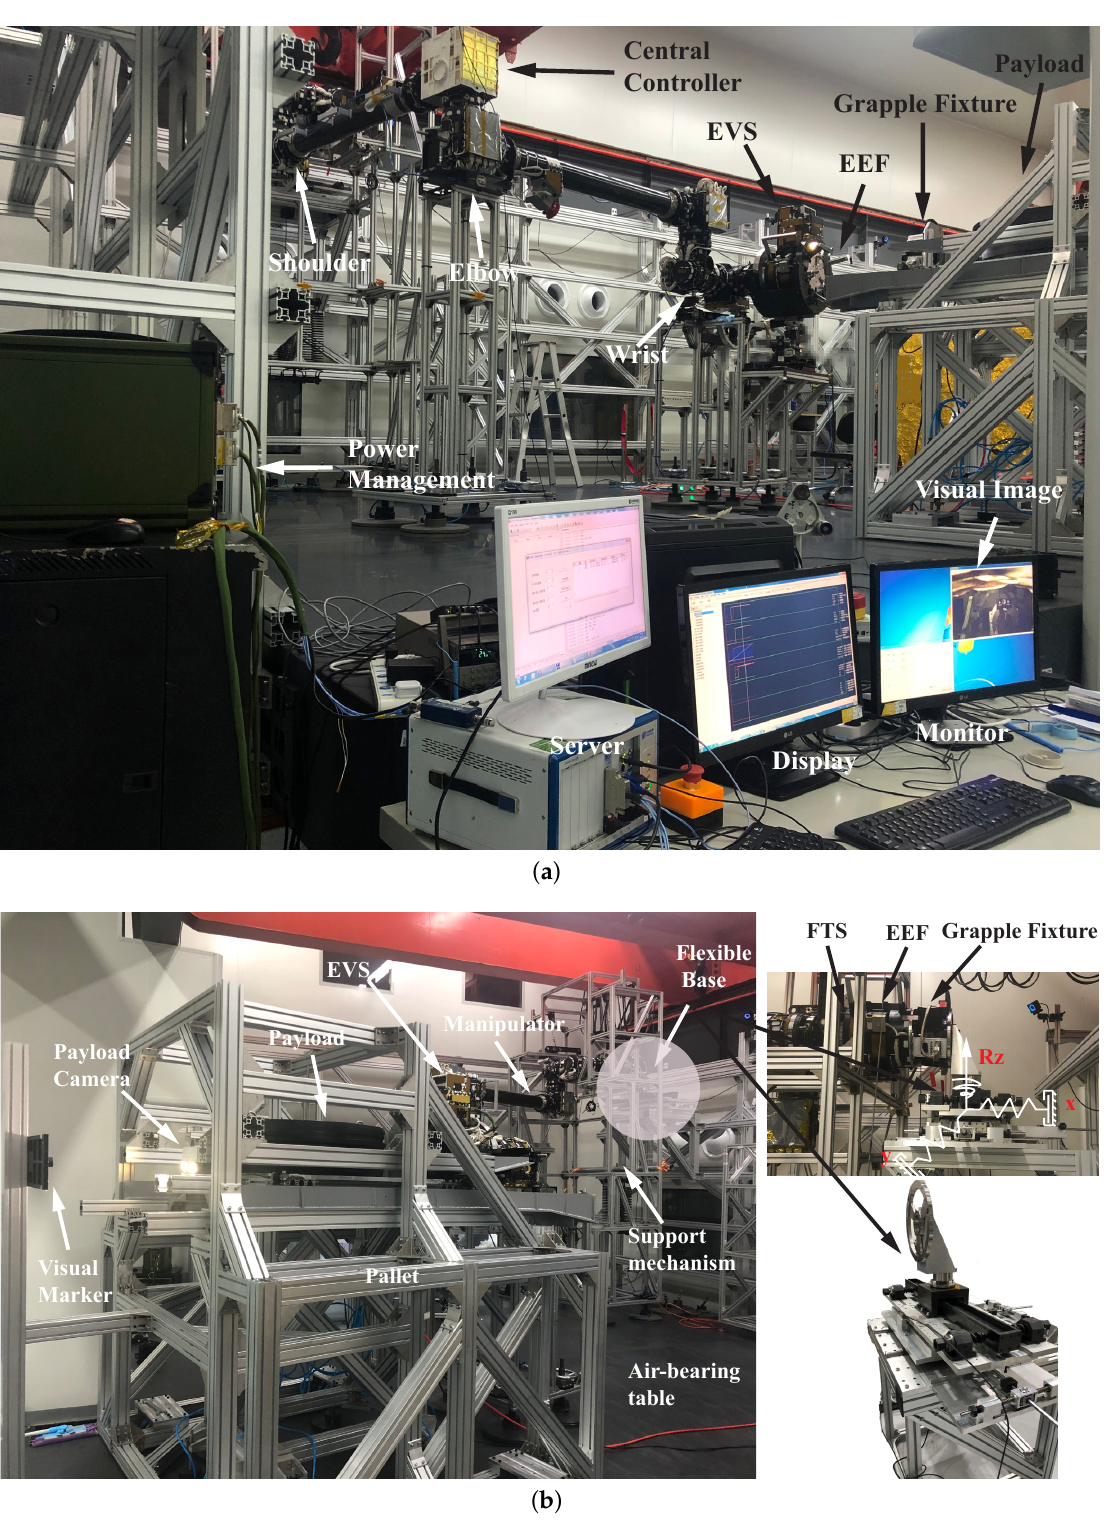
Figure 11. The setup of the ground experiment of the flexible base manipulator visual servo control. ( a )The scenario of the visual servo without payload, ( b ) the scenario of the visual servo with